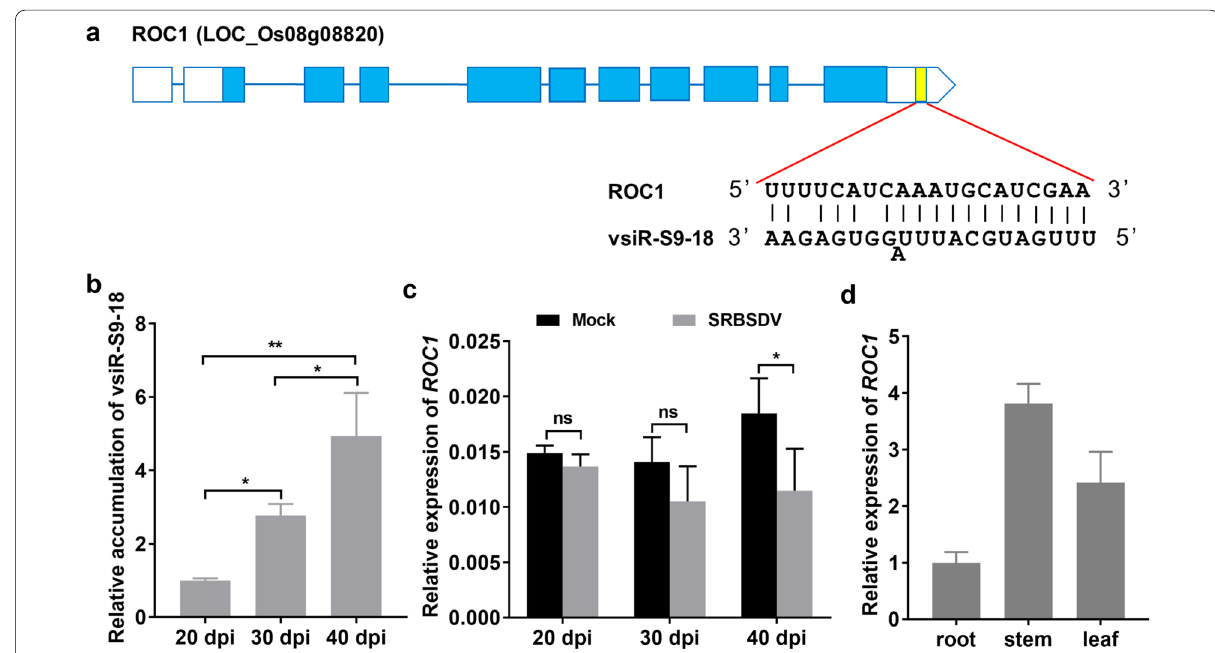
Fig. 1 Accumulation of vsiRNA and its target gene in rice plants inoculated with SRBSDV. a vsiRNA-S9-18 and its target gene ROC1 . b RT-qPCR analysis of vsiR-S9-18 accumulation in rice plants at 20, 30, and 40 dpi. OsU6 was used as an internal reference. c RT-qPCR analysis of ROC1 expression in mock- or SRBSDV-inoculated rice plants at 20, 30, and 40 dpi. d Expression pattern analysis of ROC1 in different rice tissues through RT-qPCR. The values shown are the means SD (n 3). Student’s t test was used for the analyses (* P < ± =